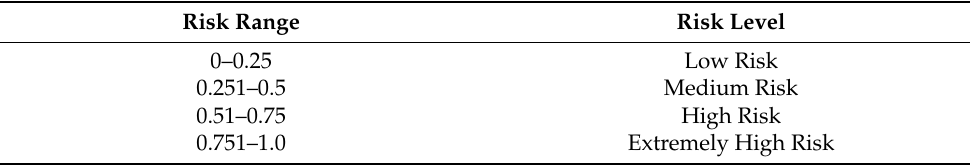
Table 6. Range of risk level